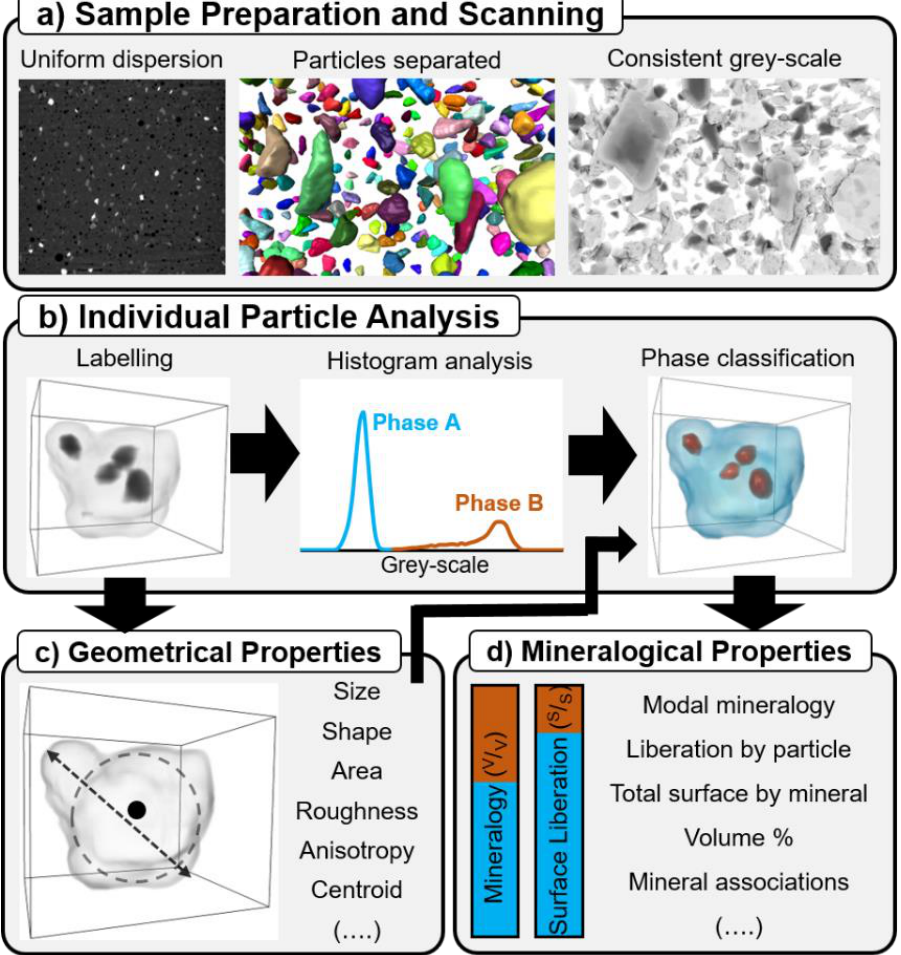
Figure 1. Scheme of the MSPaCMAn workflow. ( a ) Step 1, sample preparation and scanning; ( b ) Step 2, individual particle analysis; Step 3, ( c ) calculation of the geometrical properties of a particle, and ( d ) classification of the minerals in the sample.